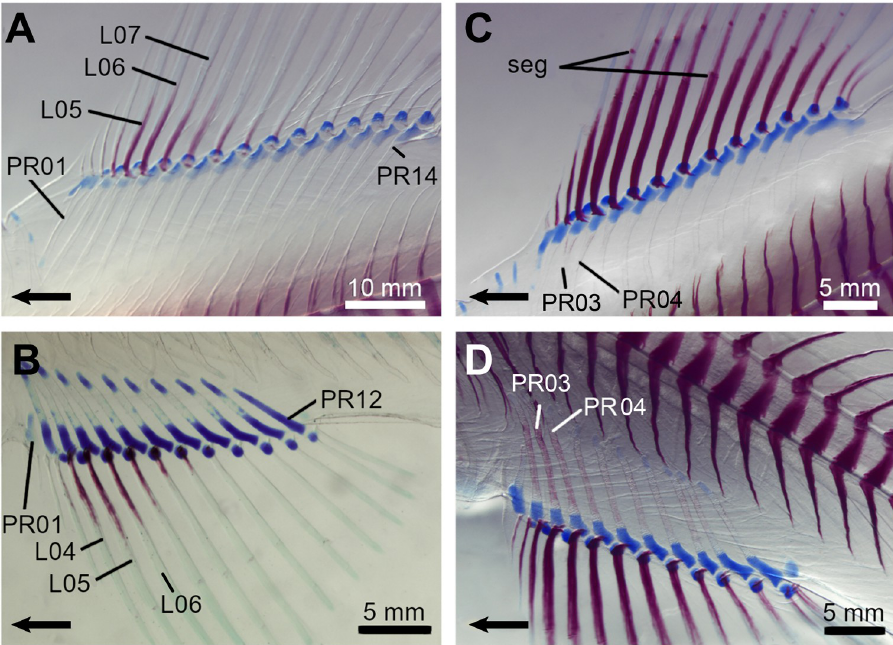
Fig 2. Cleared and stained specimens of the rainbow trout ( Oncorhynchus mykiss ). The cartilage is stained in red and the cartilages in blue. A, Dorsal fin showing the beginning of lepidotrichia ossification (specimen SL = 28.36 mm); B, Anal fin showing the beginning of lepidotrichia ossification (specimen SL = 19.80 mm). The non-stained central portion of the PR is a transitional state prior to the red stain uptake (PR ossification); C, Dorsal fin showing the beginning of radial ossification (specimen SL = 24.90 mm); D, Anal fin showing the beginning of radial ossification (specimen SL = 24.90 mm). Arrows point anteriorly. L, lepidotrichia; PR, proximal radial; seg,